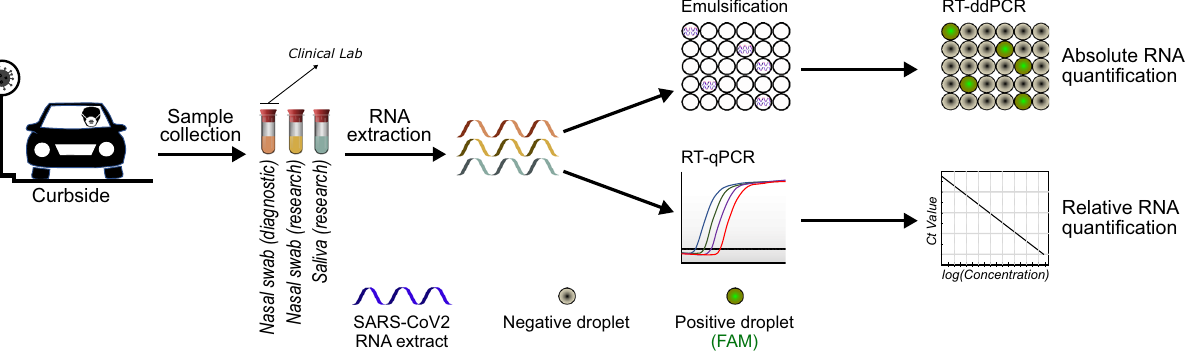
Figure 1. COVID-19 curbside patient sample collection and testing pipeline. Saliva and matched nasal swab (NS) specimens were simultaneously collected from 137 outpatients scheduled for SARS-CoV-2 testing at